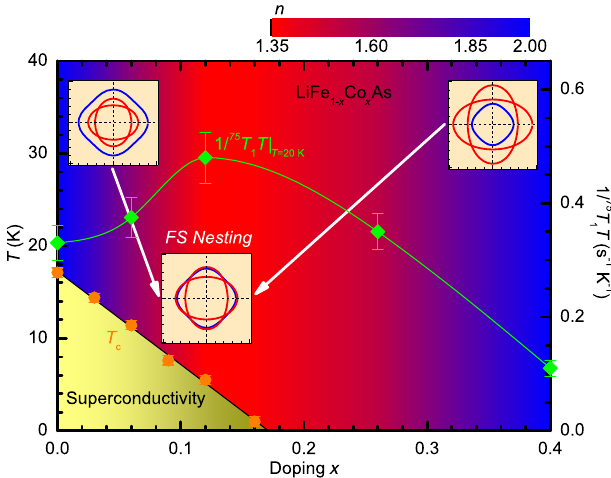
FIG. 4. Temperature-doping ( T - x ) phase diagram of LiFe 1 − x Co x As. Superconductivity (yellow regime) is monoton- ically suppressed with increasing Co concentration x and termi- nates at a critical value x ≈ 0 . 17 . The normal state of LiFeAs is a Fermi liquid (blue regime at x ¼ 0 ), where the T -dependent resistivity follows ρ ð T Þ ¼ ρ 0 þ AT n , with n ¼ 2 . A crossover from Fermi liquid to non-Fermi liquid is induced by Co doping. At x ¼ 0 . 12 , n reaches its minimum value of 1.35, indicating the most robust non-Fermi-liquid behavior (red regime). Further doping results in a reversal of this trend until by x ¼ 0 . 4 the Fermi-liquid behavior is fully recovered (blue regime at x ¼ 0 . 4 ). The green diamonds denote the spin-lattice relaxation rate at 20 K ( 1 =T 1 T j T ¼ 20 ) measured by NMR for several representative K dopings. 1 =T 1 T j T ¼ 20 reaches the maximum at x ≈ 0 . 12 , signi- K fying that low-energy spin fluctuations are optimized at this doping. The three inset panels depict the extracted Fermi surfaces for three representative Co concentrations: x ¼ 0 (left), x ¼ 0 . 12 (middle), and x ¼ 0 . 4 (right). While the Fermi surface nesting is poor for x ¼ 0 and 0.4, the nesting condition is significantly improved at x ¼ 0 . 12